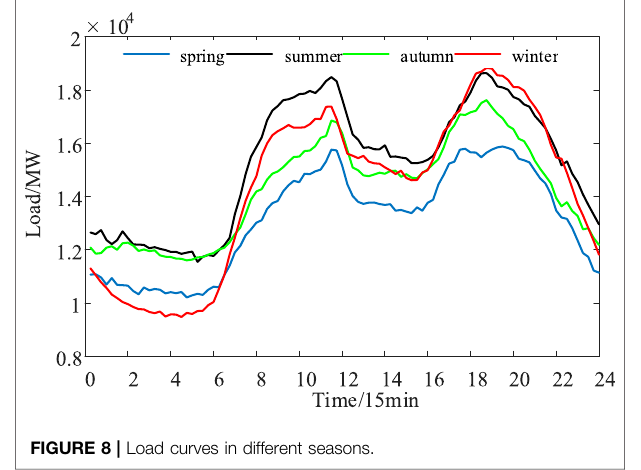
FIGURE 8 | Load curves in different seasons.